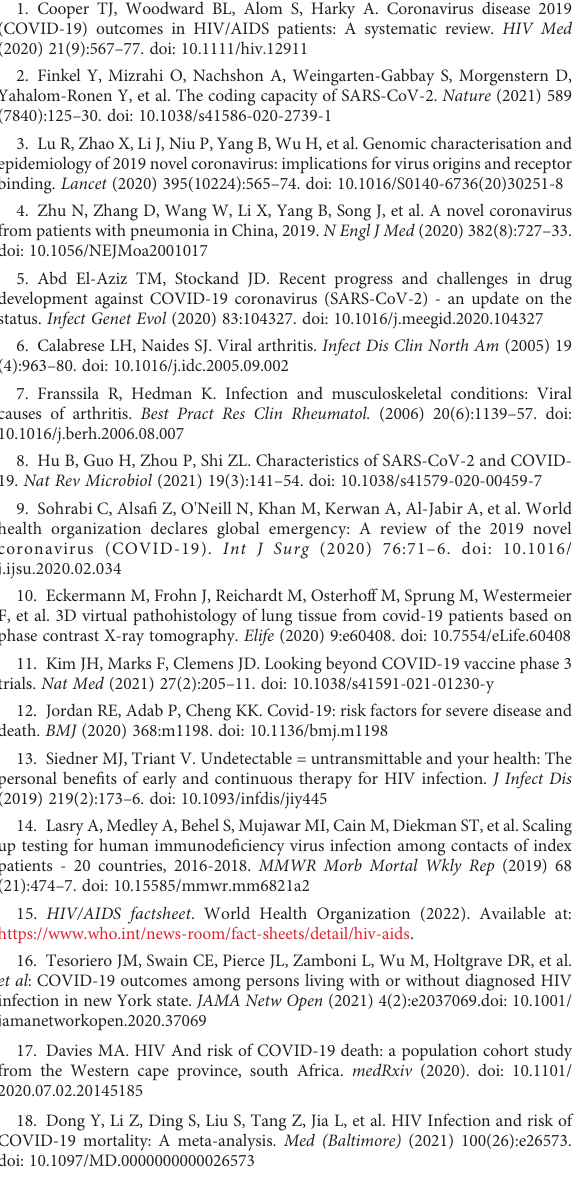
SUPPLEMENTARY TABLE 6 The TFs and their interactions with DEGs. SUPPLEMENTARY TABLE 7 The microRNAs and their interactions with DEGs. SUPPLEMENTARY TABLE 8 The potential drugs for the treatment of COVID-19 and HIV. SUPPLEMENTARY TABLE 9 Regulatory interactions between common DEGs and